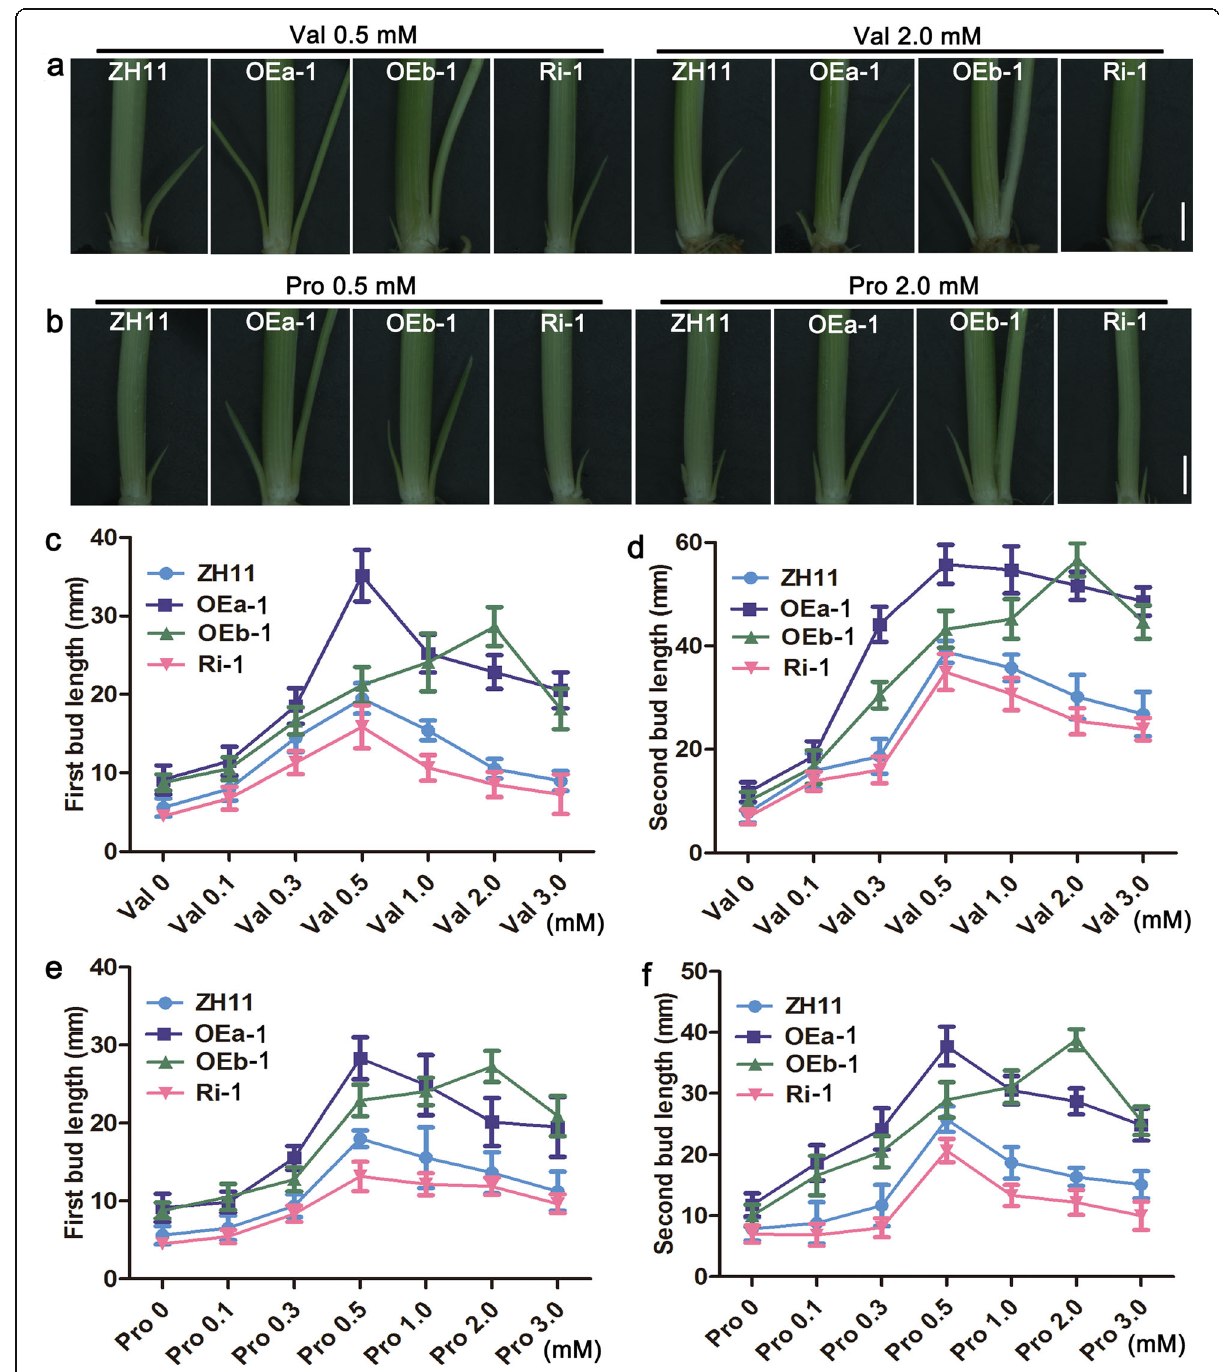
Fig. 5 Effect of different concentrations of Val and Pro on bud outgrowth among ZH11, OEa, OEb, and Ri lines grown in hydroponic culture. Phenotypes of outgrowth buds among ZH11, OEa, OEb, and Ri lines grown with 1.0 mM NH 4 NO 3 and 0.5 mM Val and 2.0 mM ( a ), 0.5 mM Pro and 2.0 mM Pro ( b ). Quantification of the first bud ( c ) and second bud ( d ) under different concentrations of Val. Quantification of the first bud ( e ) and second bud ( f ) under different concentrations of Pro. Scale bars, 1.0 cm ( a , b ). Values are means ± s.d. ( n >